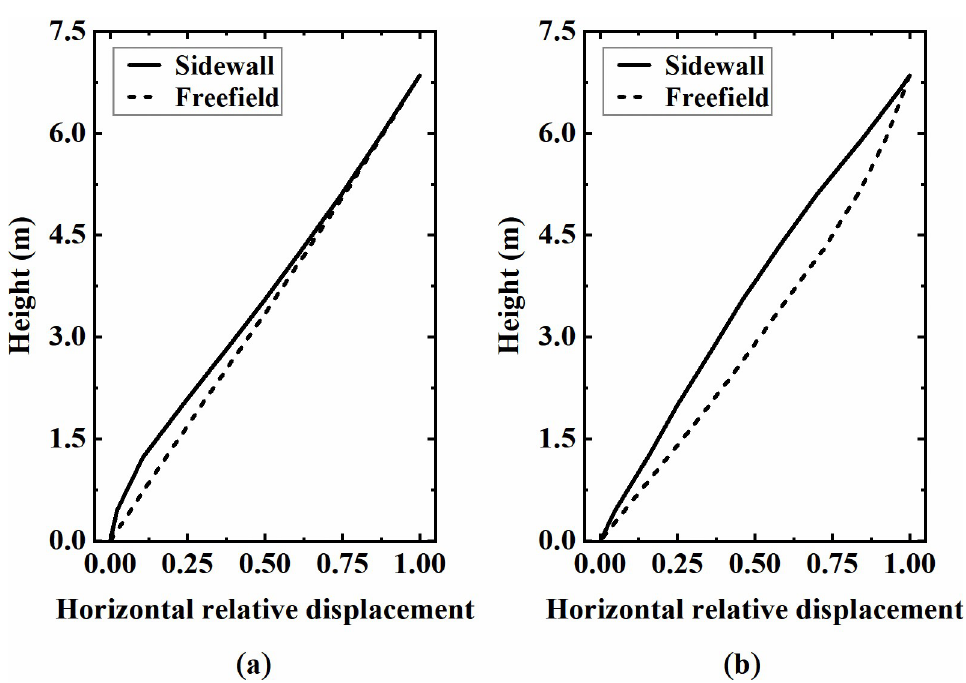
Fig 20. Horizontal displacement of the lower sidewall and free field soil. (a) Site 1, F = 10.26, (b) Site 5, F = 1.23.